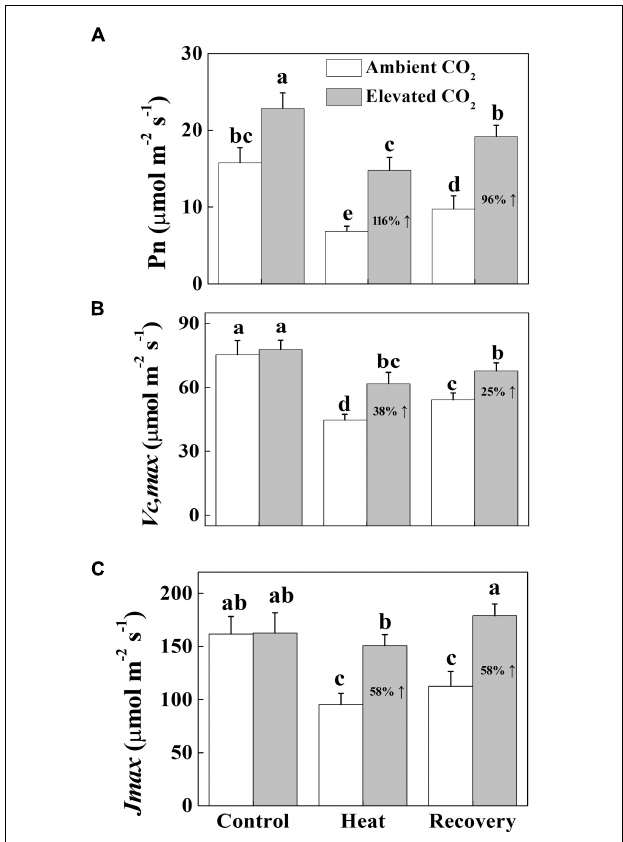
FIGURE 1 | Effects of elevated CO 2 and heat stress either alone or combined on the CO 2 assimilation capacity in tomato leaves. (A) the net photosynthetic rate (P n ); (B) the maximum carboxylation rate of RuBisCO ( V cmax ), (C) the maximum rate of RuBP regeneration ( J max ). At the four-leaf stage, tomato seedlings were exposed to either ambient (380 µ mol mol − 1 ) or elevated CO 2 concentration (800 µ mol mol - 1 ). After an acclimation period of 48 h, half of the seedlings from both CO 2 conditions was challenged with a 24 h heat stress (42 ◦ C temperature) and then allowed to recover for 24 h. Measurements were taken on the third fully expanded leaves using an open-flow infrared gas analyzer adapted with light and temperature control systems (Li-COR 6400, Li-COR, Lincoln, NE, United States). The results are expressed as the mean values ± SD, n = 6. Different letters above the bars indicate significant differences at P < 0.05 according to Tukey’s